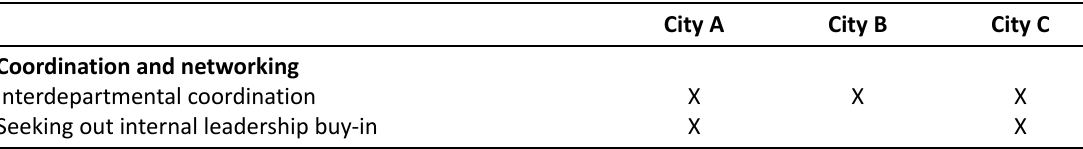
Table 3. Planners’ discretionary strategies for encouraging sustainable